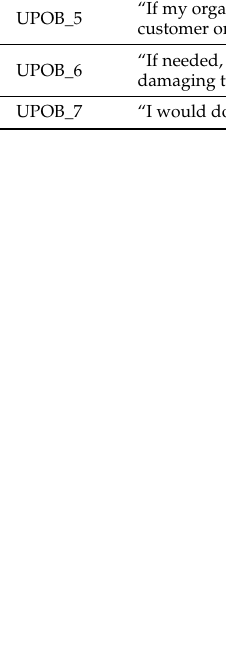
Table 3. First order factor analysis Convergent and discriminant